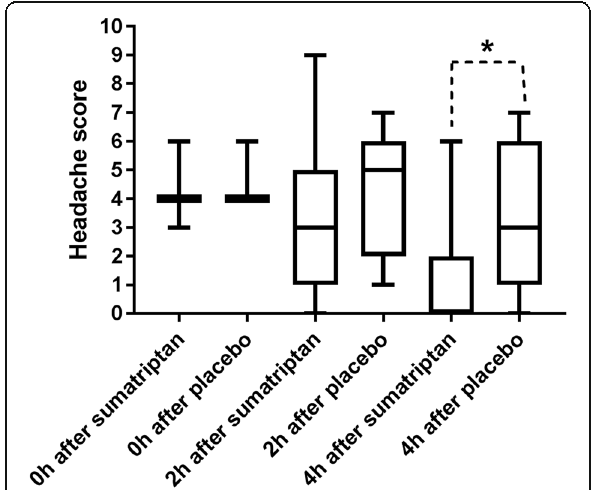
Fig. 5 Median headache intensity after treatment of spontaneous migraine attacks. Median headache score at different time points after treatment of spontaneous migraine attacks. Difference in median headache intensity at 2 h: p = 0.26. Difference in median headache intensity at 4 h: p =